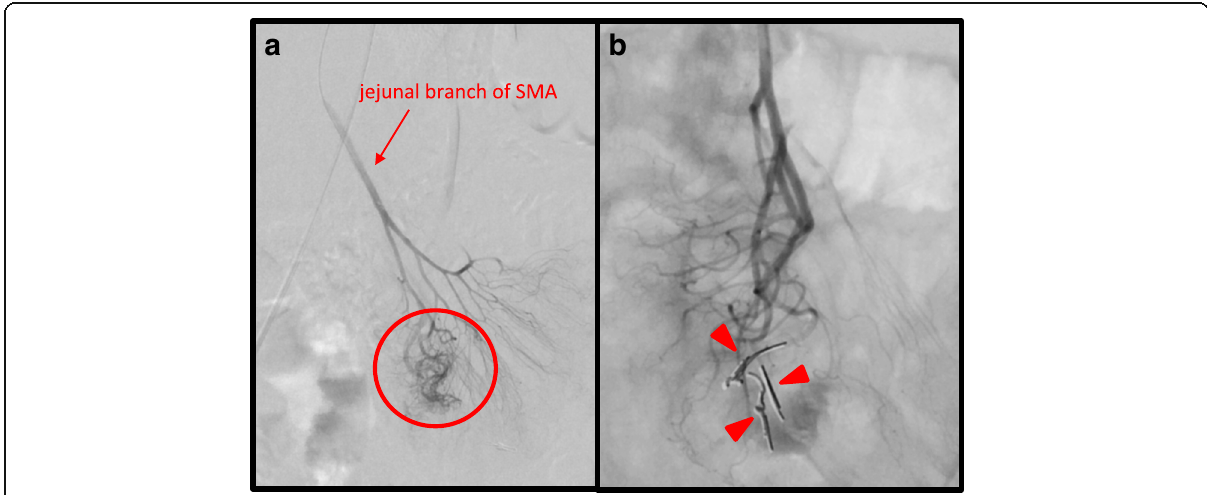
Fig. 1 Selective angiography of the SMA. a Extravasation (red circle) from the jejunal branch of the SMA (red arrow) supplying the AVM is clearly observed. b Three vasa recta branches of the jejunal branch embolized with metallic coils (red arrowheads), with no extravasation from the AVM evident after coil